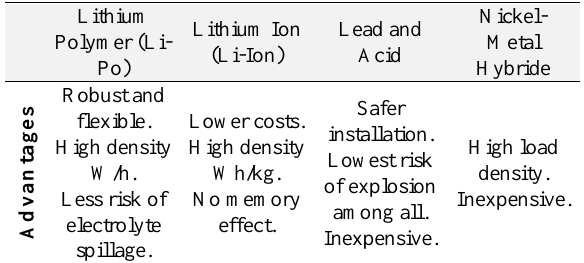
Table 3. Types of batteries.